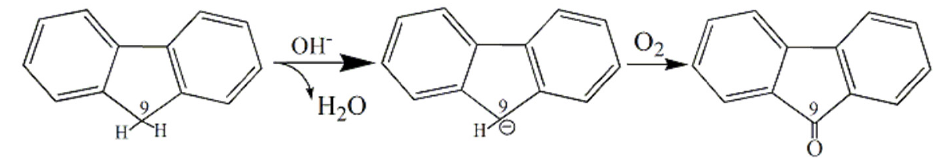
Figure 1. The oxidation pathway of FLU.